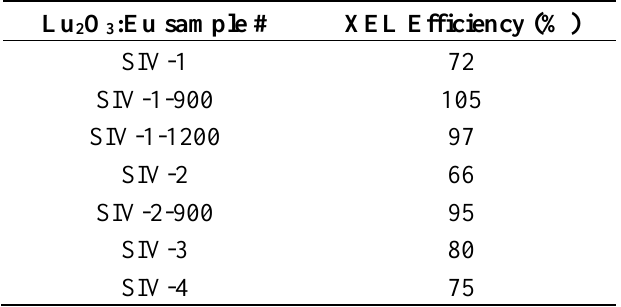
Table 3. XEL efficiency of Lu 2 O 3 :Eu vs. commercially offered Gd 2 O 2